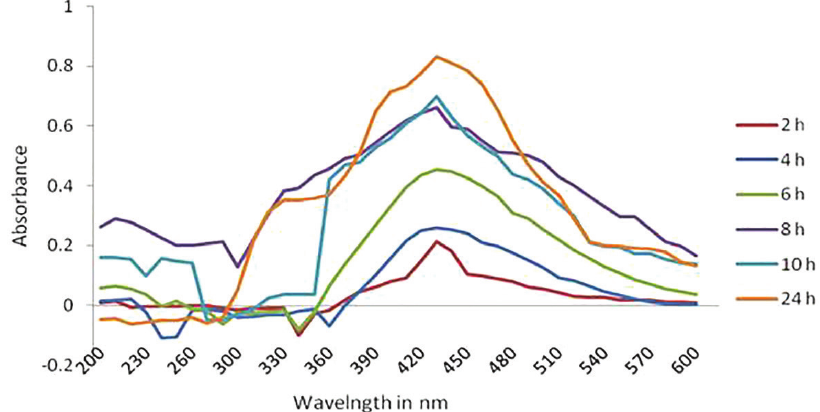
FIGURE 2 - UV spectrophotometric measurements at 2, 4, 6, 8, 10 and 24 h of incubation of cell filtrate with AgNO